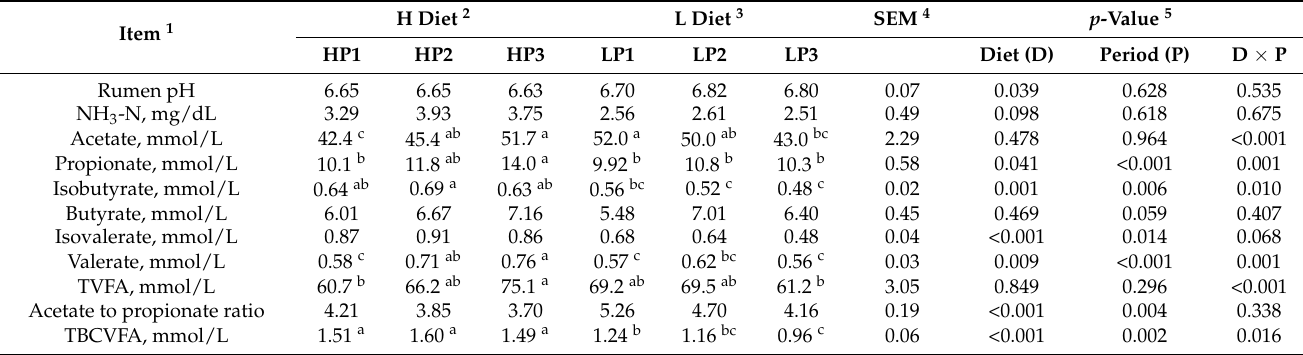
Table 4. Rumen fermentation characteristics over three collection periods in high- and low-density